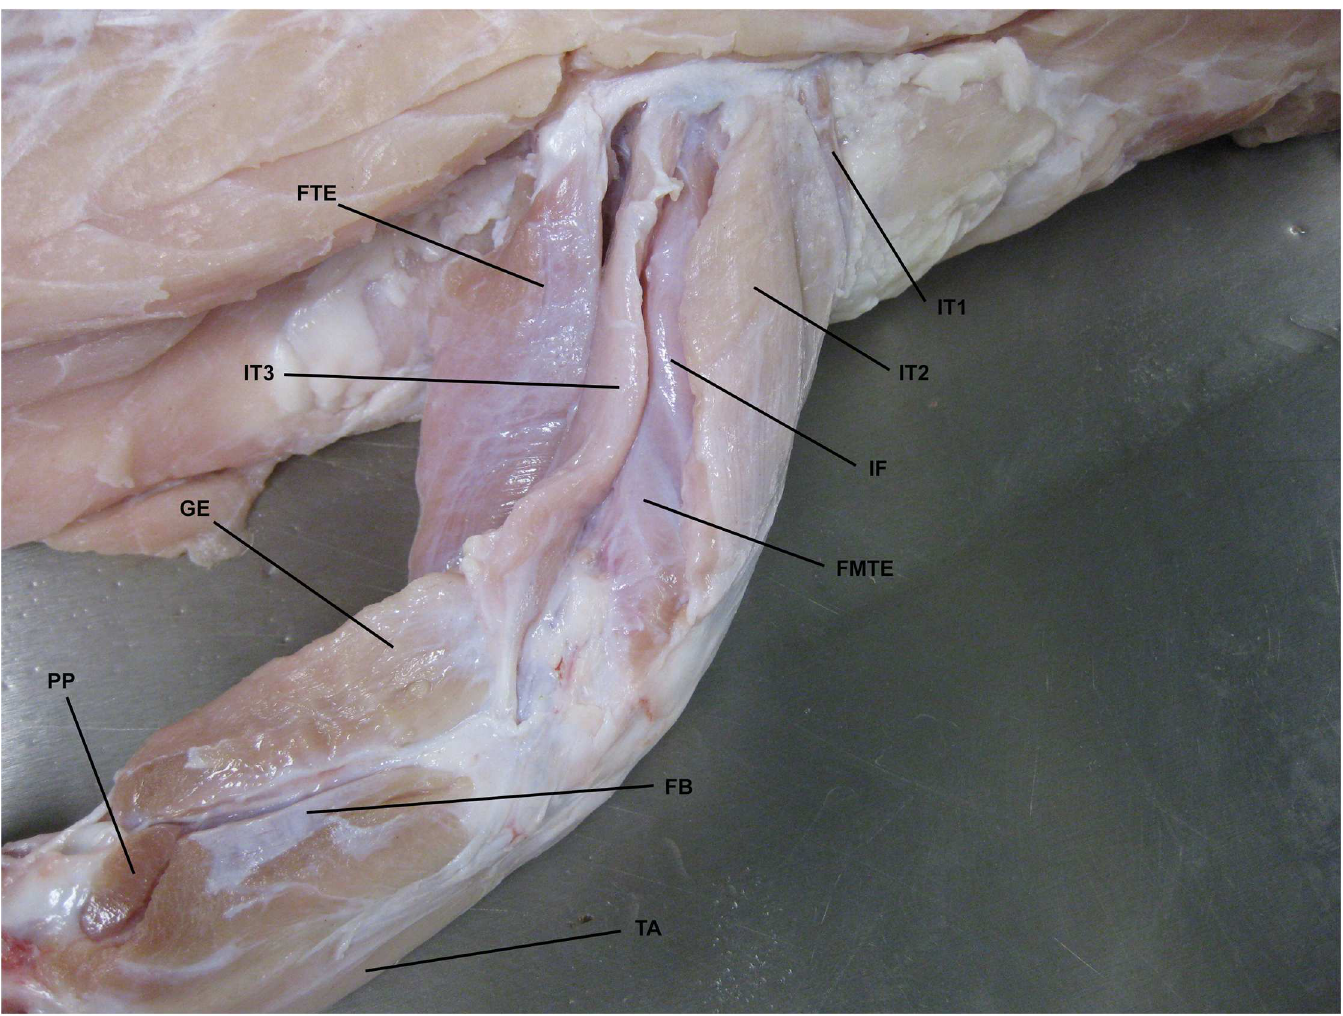
Fig 4. Fresh-tissue dissection with some hindlimb muscles identified. Dorsolateral view of right hindlimbof Crocodylusporosus (XCb Cp5). FTE: flexor tibialisexternus , IT1-3: Iliotibialis1–3 , IF: Iliofemoralis , FMTE: Femorotibialis externus , GE: Gastrocnemius externus , PP: Pronator profundus , FB: Fibularis brevis , TA: Tibialis anterior .